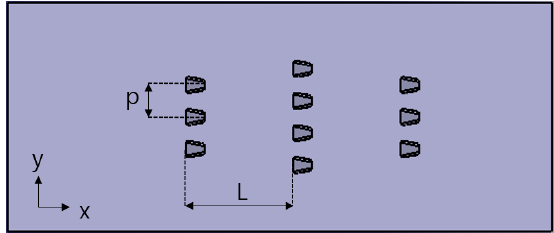
Figure 3. Schematic of staggered arrangement test section.